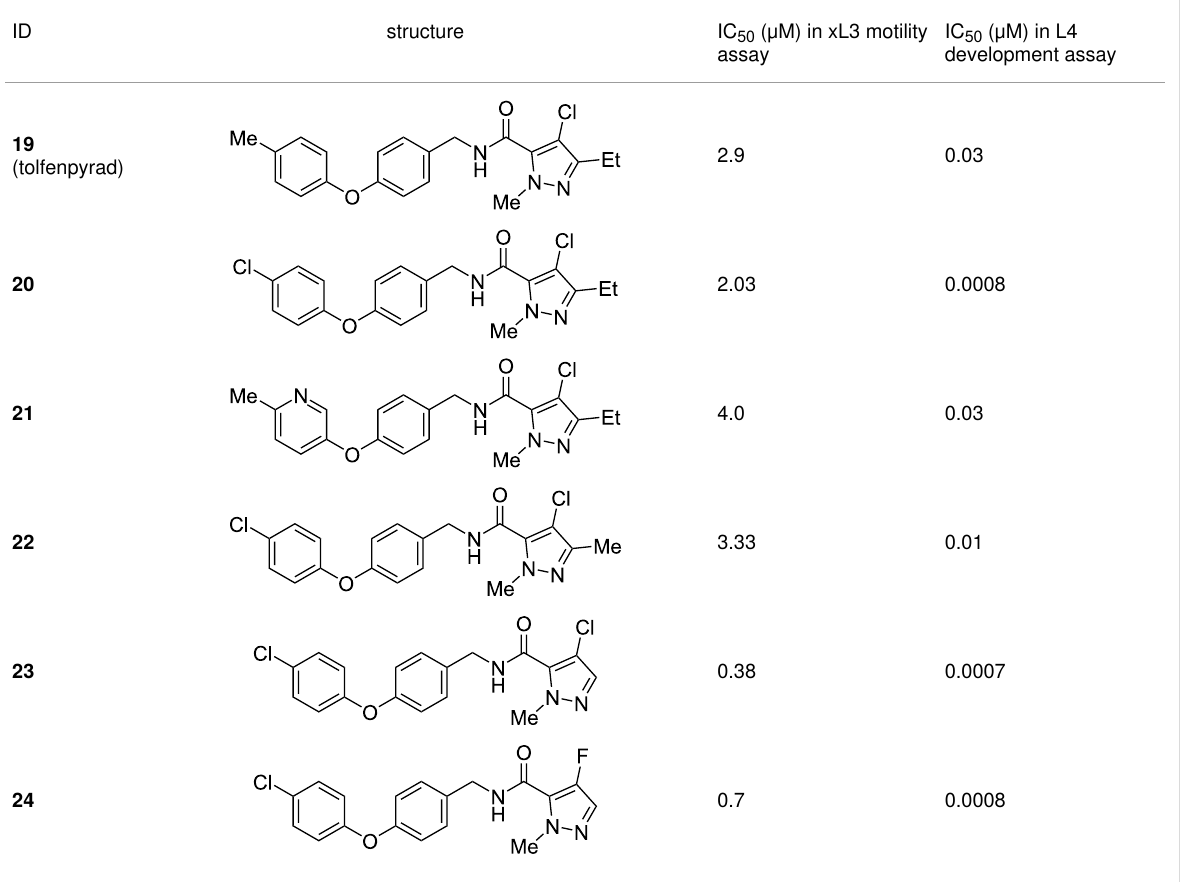
Table 4: Potent anthelmintic activity of tolfenpyrad ( 19 ) derivatives against H. contortus. The activity is shown for two in vitro assays: one for motility of xL3 (exsheathed L3 stage worms) and a second for development of xL3 into the L4 stage [169].